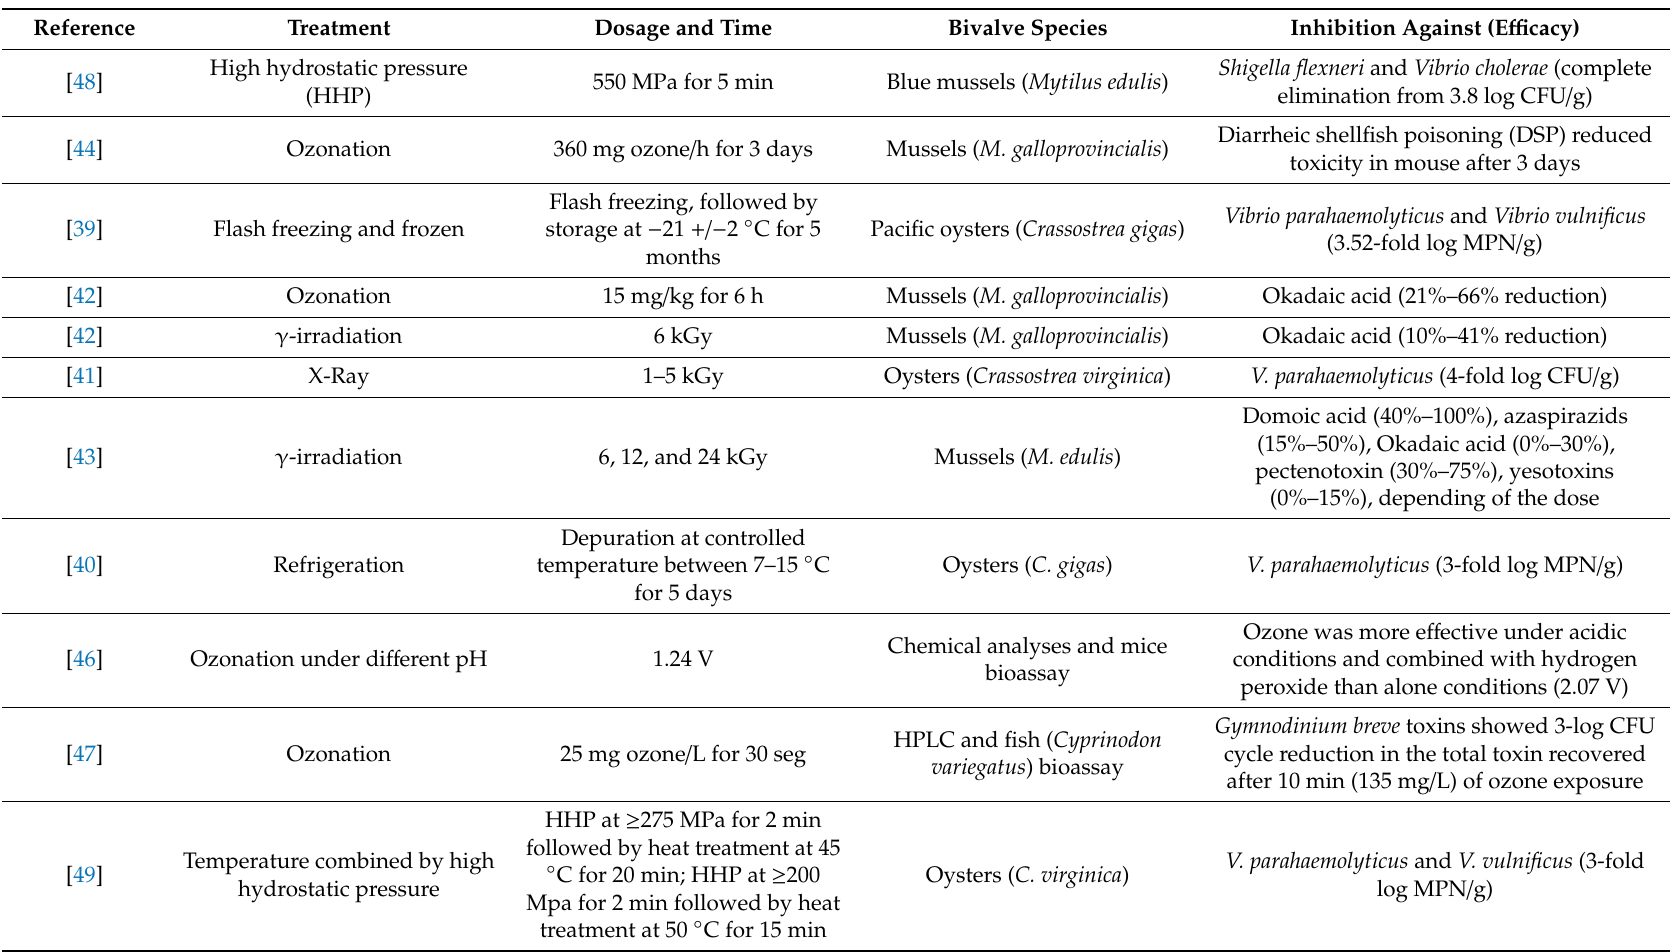
Table 3. Complementary depuration methods using physical